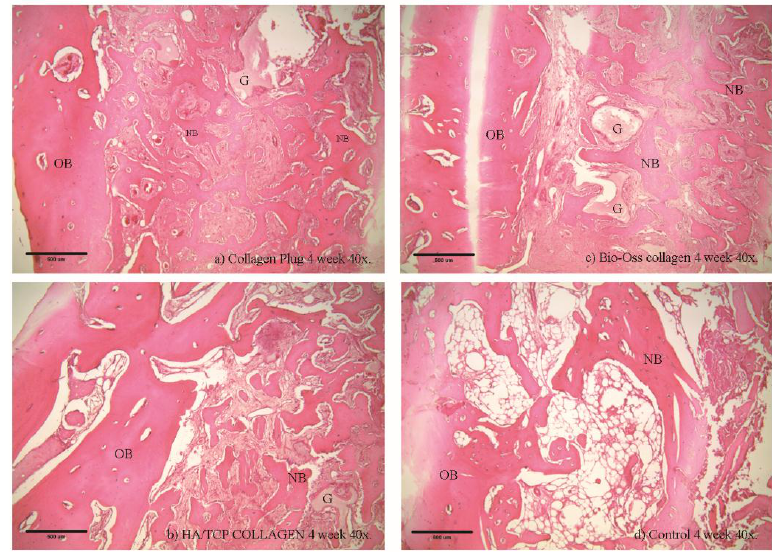
Figure 5. Histological examination at the fourth week using 40× magnification Histological analysis of the collagen ( a ), bovine xenograft-collagen composite ( b ), hydroxyapatite/β-tricalcium phosphate (HA/β-TCP)-collagen composite ( c ) and control groups ( d ). Hematoxylin and eosin staining; original magnification: 40×. Abbreviations: NB, newly-formed bone; OB, old bone; G, granule residual.